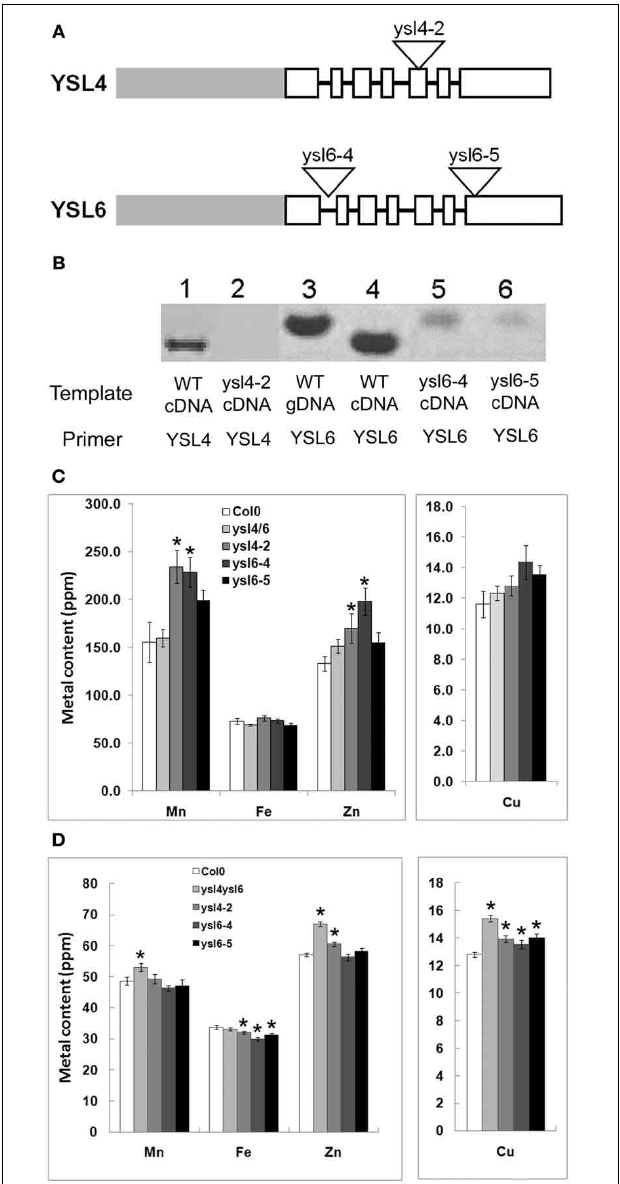
FIGURE 6 | ysl4-2, ysl6-4 and ysl6-5 null mutants. (A) Schematic representation of the structure of AtYSL4 and AtYSL6. Gray bars represent promoter regions. White boxes represent exons. Black lines represent introns (not to scale). Triangles represent insertion sites of T-DNAs in the Salk T-DNA insertion mutants, ysl4-2 (SALK_025447),ysl6-4 (SALK_119560), and ysl6-5 (SALK_093392). (B) Detection of AtYSL4 and AtYSL6 mRNA. RT-PCR was performed using RNA extracted from the leaves of wild type (WT), ysl4-2, ysl6-4, ysl6-5, and ysl4ysl6 plants. WT genomic DNA (gDNA) was also included as a control. Lane 1: WT cDNA with AtYSL4 specific primers. Lane 2: ysl4-2 cDNA with AtYSL4 specific primers. Lane 3: WT gDNA with AtYSL6 specific primers. Lane 4: WT cDNA with YSL6 specific primers. Lane 5: ysl6-4 cDNA with YSL6 specific primers. Lane 6: ysl6-5 cDNA with AtYSL6 specific primers. (C) and (D) ICP-MS determination of metal concentrations of Col-0, ysl4-2, ysl6-4, ysl6-5, and ysl4ysl6. Results are given as ppm. Error bars represent standard error. Each sample contains 10 replicates. Asterisks indicate P < 0 . 05 by t -test. (C) Metal concentrations of leaves. (D) Metal concentrations of